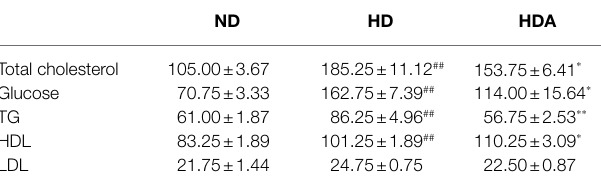
TABLE 1 | Biochemical parameter of